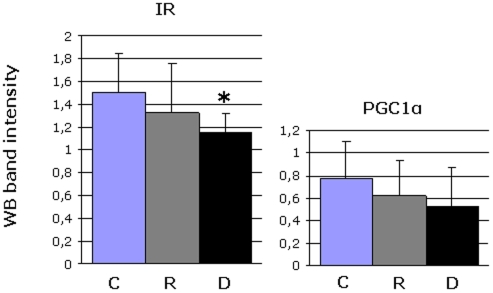
Protein expression of IR and PGC1α.Western blot (WB) analyses were performed for the IR and PGC1α for all samples used in the microarray study in order to verify mRNA results on protein level. Band intensities were determined and the average result for each group is shown in this figure. The only significant difference between groups was found to be a downregulation of the IR in the diabetic group compared to controls (unpaired t-test, p-value <0.05). This result fits with what was observed in the microarray study.